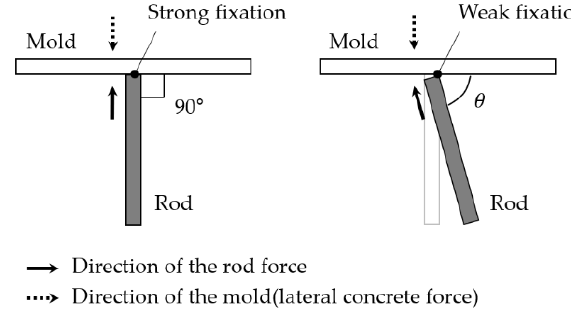
Figure 5. Force according to the angle of the rod and mold.